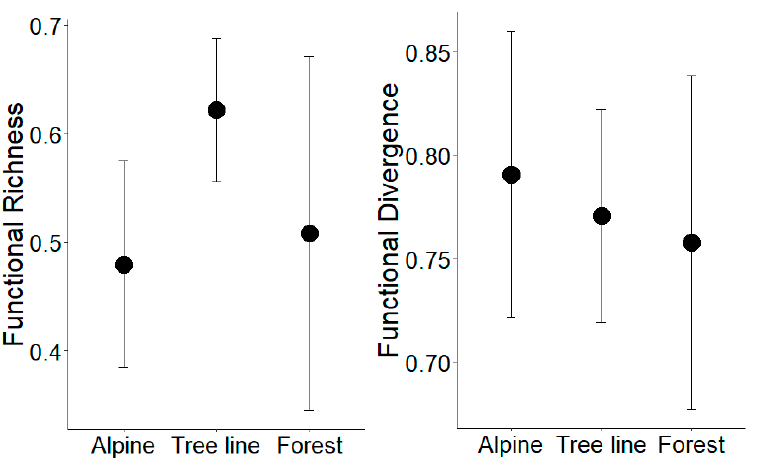
Figure 5. Means ± 95% confidence intervals of two functional diversity measures, functional rich- ness and functional divergence, based on a matrix of 28 traits per species. A higher score on the tree line compared to the alpine sites was detected for functional richness only.